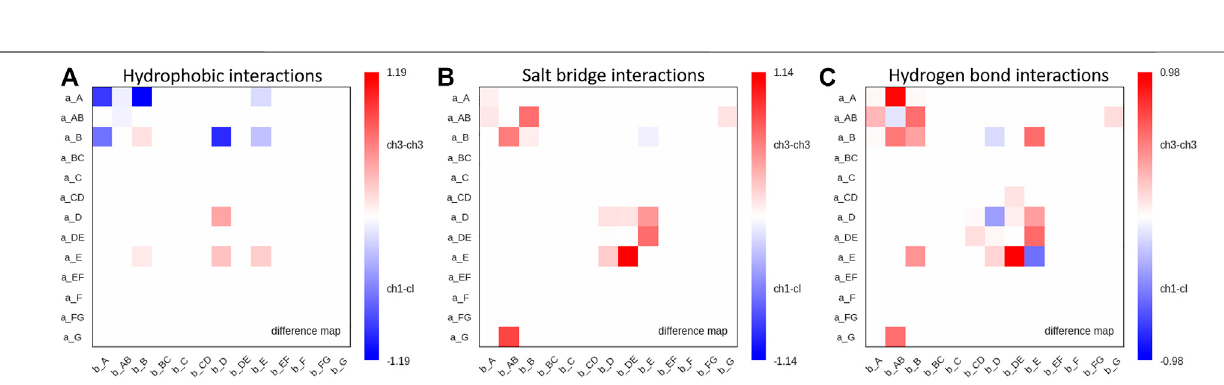
Frontiers in Molecular Biosciences |